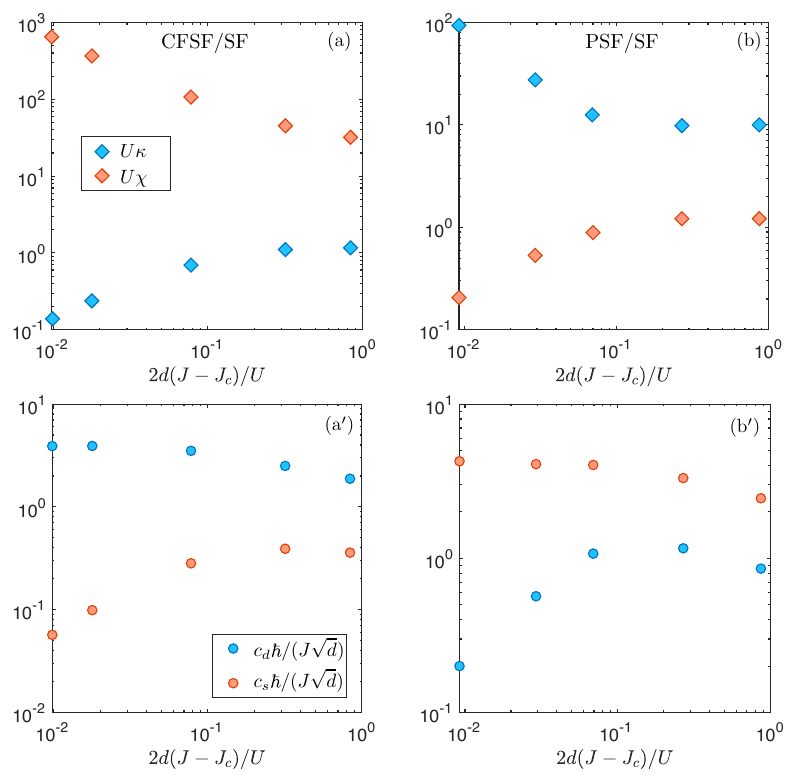
Figure 8: Upper panels: dependence of the compressibility (blue diamonds) and susceptibility (red diamonds) in the vicinity of the O ( 2 ) (a) CFSF and (b) PSF transi- tions. Lower panels: dependence of the density (blue circles) and spin (red circles) sound velocities close to the same transitions. The data in (a) and (a ′ ) correspond = 1 and U / U = 0.9, while the data in (b) and (b ′ ) are derived for fixed to fixed n d 12 ≈ 1.47 and U / U = − 0.7. The calculations are always performed for d = n d 12